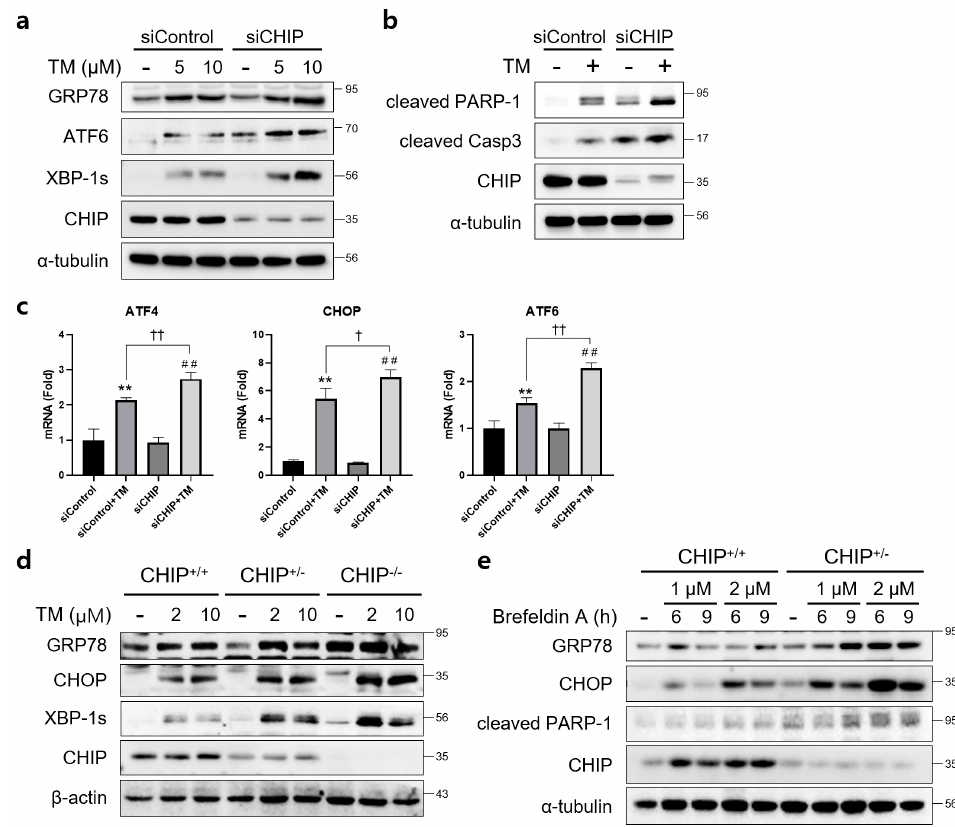
Figure 1. CHIP is involved in unfolded protein responses (UPRs) and apoptosis in hepatocytes. ( a ) AML12 cells were transfected with control (siControl) or CHIP siRNA (siCHIP) for 48 h and then treated with tunicamycin (TM, 5 or 10 µ M) for 24 h. Protein levels of GRP78, ATF6, XBP-1s and